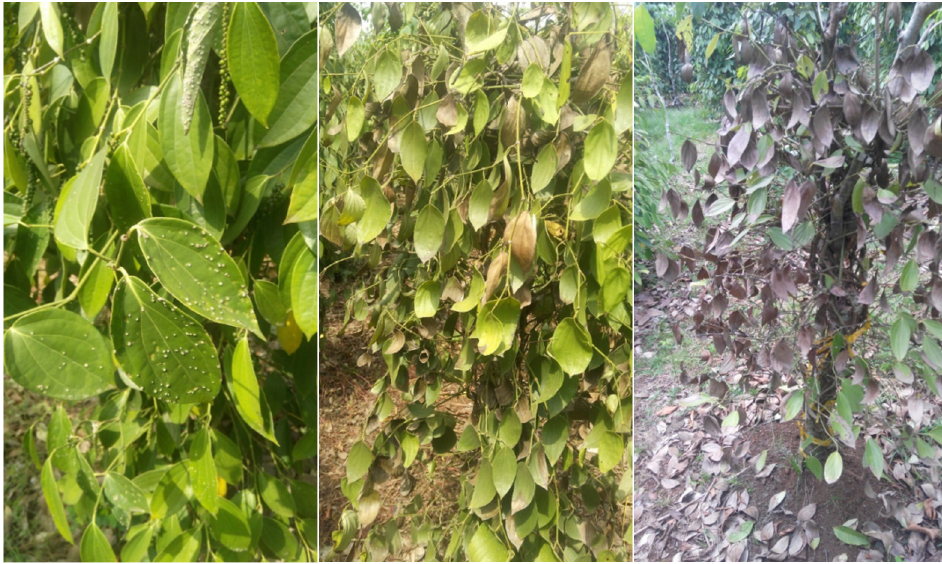
Figure 3. Nematodes facilitate gall diseases and fungi contamination; a defoliated plant after fungi attack (Njombe, Cameroon).